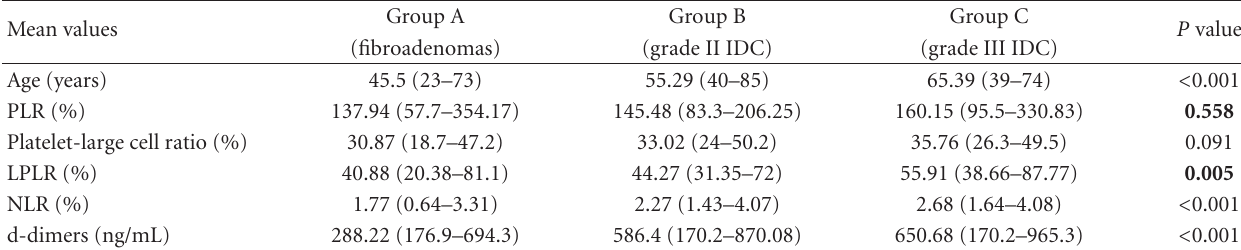
Table 1: Display and comparison of the evaluated parameters of our study sample.